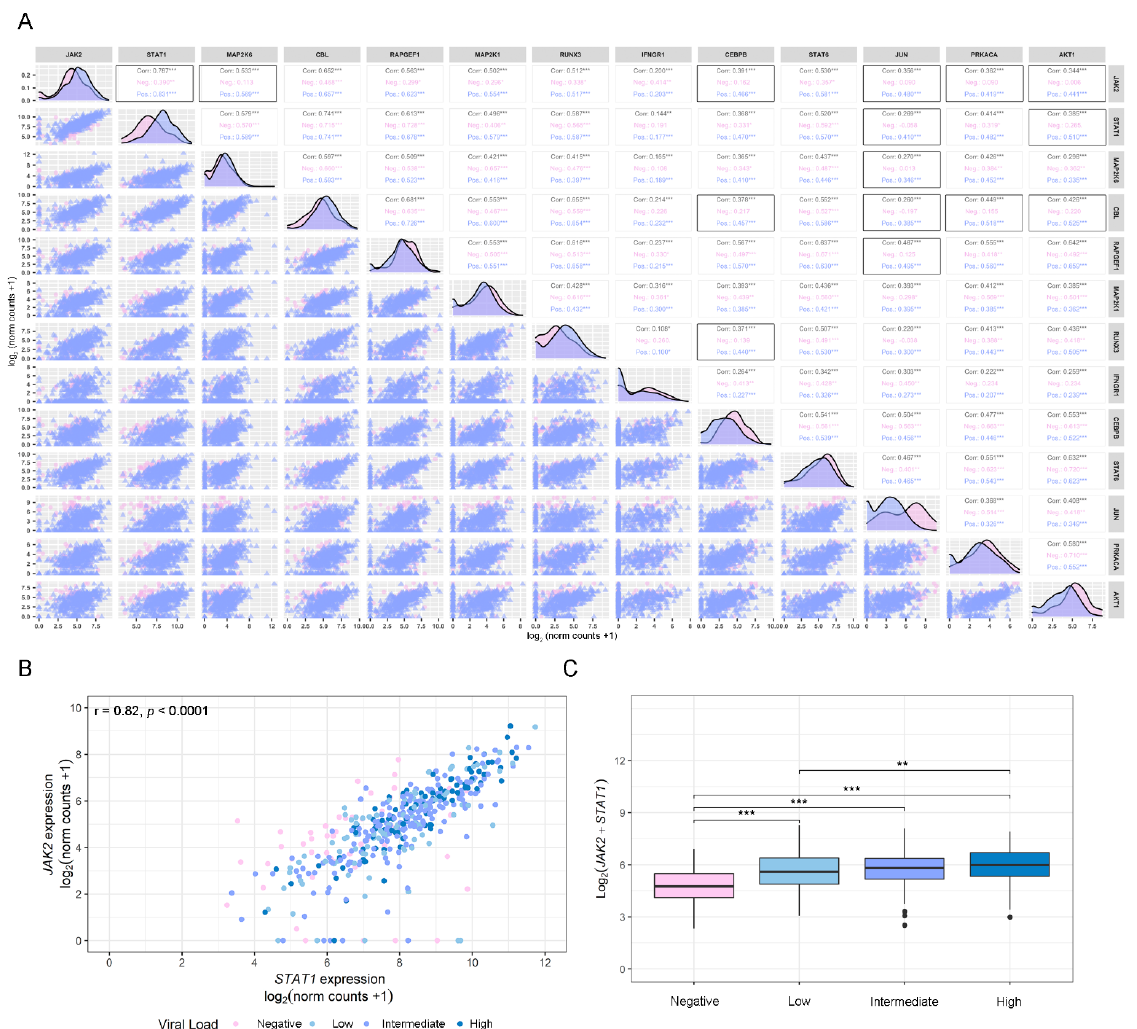
Figure 3. Correlation analysis. ( A ) Pairwise Spearman correlation matrix analysis between all genes of interest using the GSE152075 dataset. The upper half displays the Spearman coefficients (r) considering all patients (Corr.; black), non-COVID-19 patients (Neg.; pink), or COVID-19 patients (Pos.; purple). Black boxes highlight pairs of genes that have significant correlation only in COVID-19-positive patients, except for JAK2 / STAT1 , which was the pair with the highest coefficient in COVID-19-positive patients. The lower half displays the scatterplots. ( B ) Dot plot representing pairwise Spearman correlation for JAK2 and STAT1 , considering viral load in COVID-19-positive patients from the GSE152075 dataset. Viral load is represented as a color scale and was categorized as Negative (pink), Low (first quartile; light blue), Intermediate (second and third quartile; purple), or High (fourth quartile; blue), and was considered as an independent variable expressed as cycle threshold (Ct) by RT-qPCR for the N1 viral gene at time of diagnosis. The interpretation for viral load is the lower the Ct, the higher the viral load. ( C ) Box plot representing the combined expression of JAK2 + STAT1 and their association with the viral load. Viral load was categorized as Negative (pink), Low (first quartile; light blue), Intermediate (second and third quartile; purple), or High (fourth quartile; blue). p -values correspond to Wilcoxon rank-sum test. Statistical significance * p < 0.05; ** p < 0.01; *** p < 0.001.